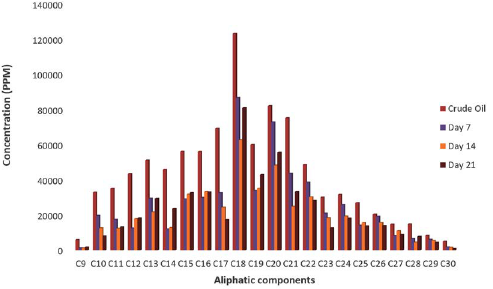
Fig. 5. Concentrations of aliphatic compounds in